Question: Condense the content of this figure into a single sentence.
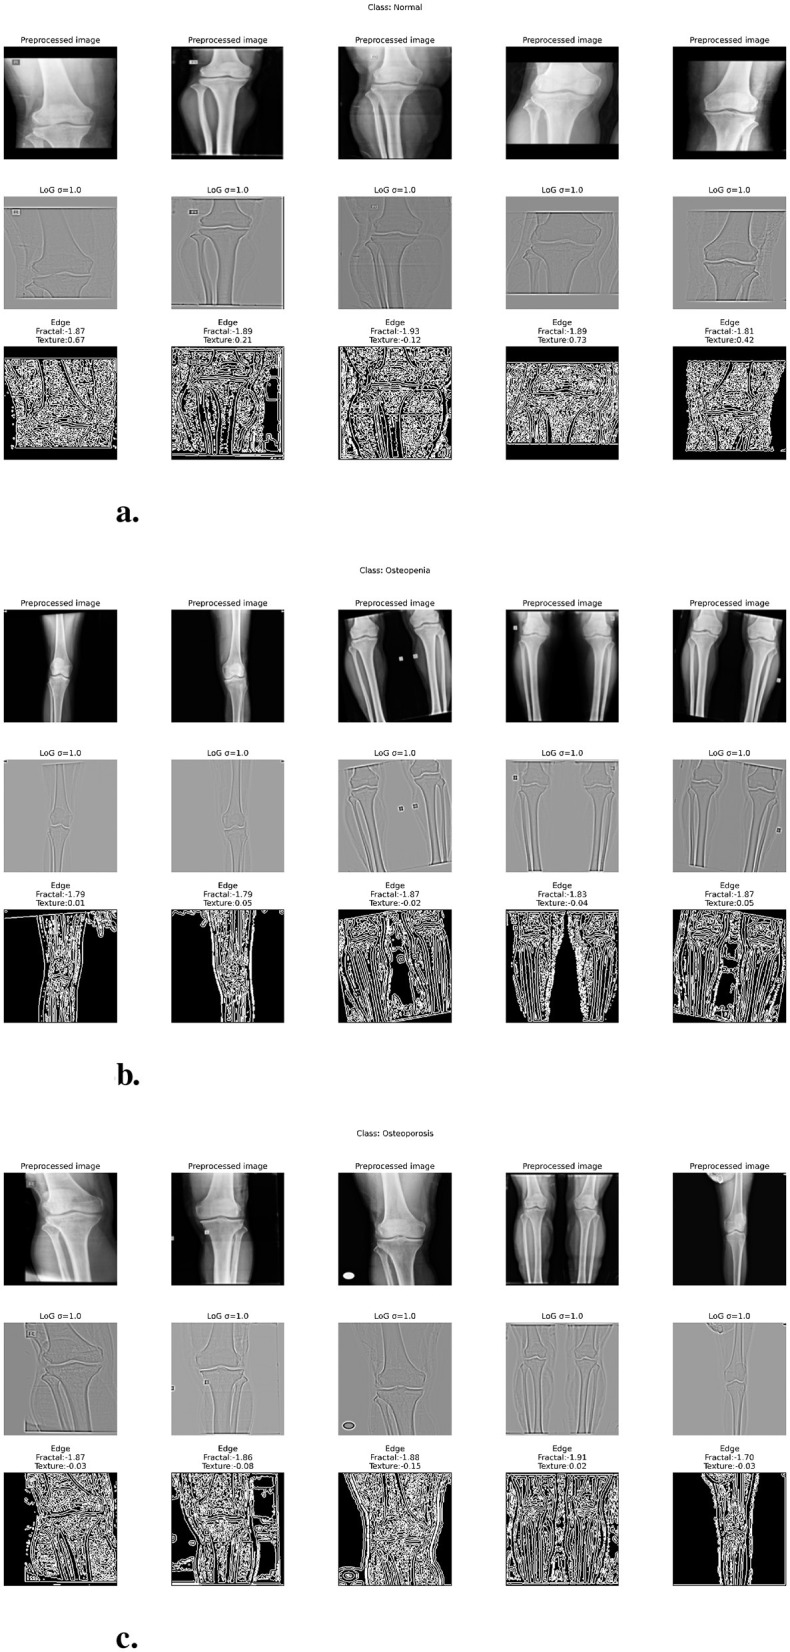
Answer: Illustrates the image feature extraction process applied to three diagnostic classes: Normal, Osteopenia, and Osteoporosis for the Multi-Class Knee Osteoporosis X-ray Dataset. (a) Edge, fractal structure, texture feature extraction using normal images. (b) Edge, fractal structure, texture feature extraction using Osteopenia images. (c) Edge, fractal structure, texture feature extraction using osteoporosis images.